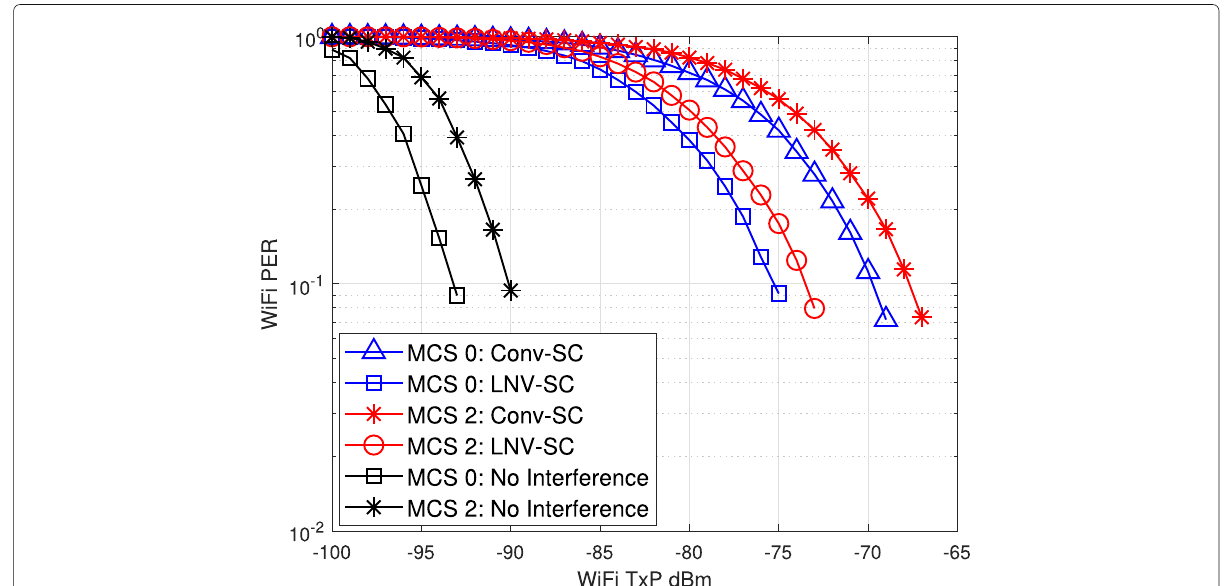
Fig. 12 LNV-SC vs Conv-SC for a single-antenna WiFi receiver in the presence of two narrowband interferers. LNV-SC achieves more gain in SNR compared to Conv-SC for all the WiFi MCS, although the gain decreases as the MCS increases